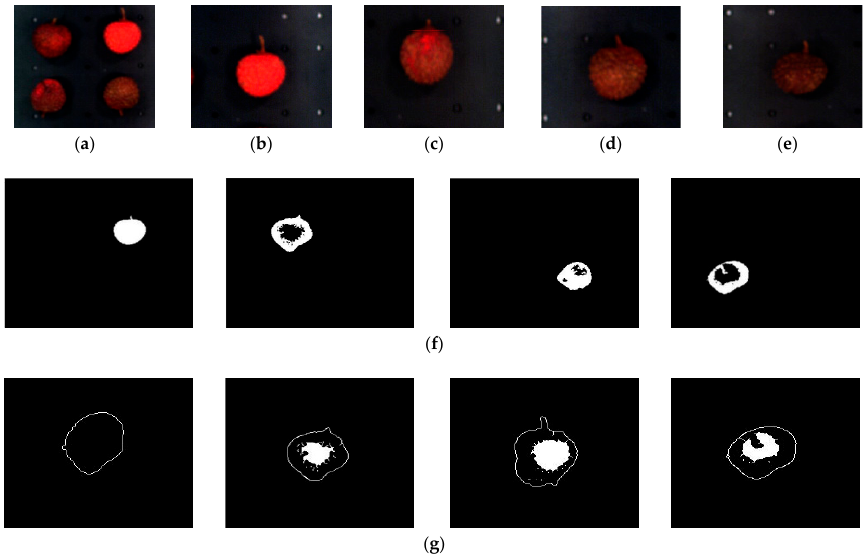
Figure 10. Image processing results of different qualities of litchis. ( a ) Hyperspectral image, ( b ) Fresh, ( c ) Newly damaged, ( d ) 2 h after damage, ( e ) 4 h after damage, ( f ) Results of Otsu adaptive threshold segmentation (left to right), Fresh, newly damaged, 2 h after damage, 4 h after damage, ( g ) Results of edge detection and fuzzy clustering (left to right), Fresh, Newly damaged, 2 h after damage, 4 h after damage.